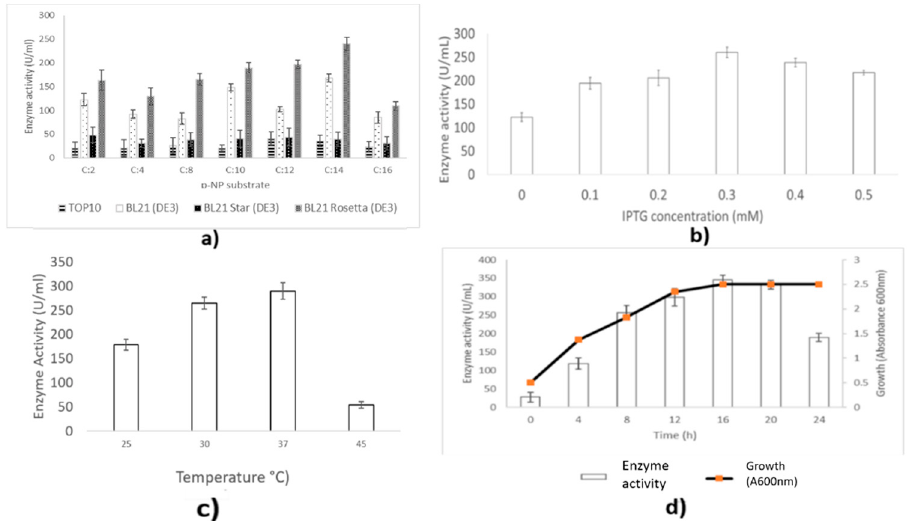
Figure 4. Optimization of LIP2 lipase production. ( a ) Effect of host strains on lipase expression. ( b ) Effect of inducer (IPTG) concentration for LIP2 lipase secretion at A 600nm 2.2. ( c ) Effect of temperature on expression of LIP2 lipase by E. coli Rosetta (DE3) harboring pET51b+/LIP2 at A 600nm 2.2. ( d ) Effect of post-induction times on LIP2 lipase production secretion by E. coli Rosetta harboring pET51b+/LIP2. Error bars indicate standard deviation of means ( n = 3). The absence of a bar indicates that errors were smaller than symbols and lines.